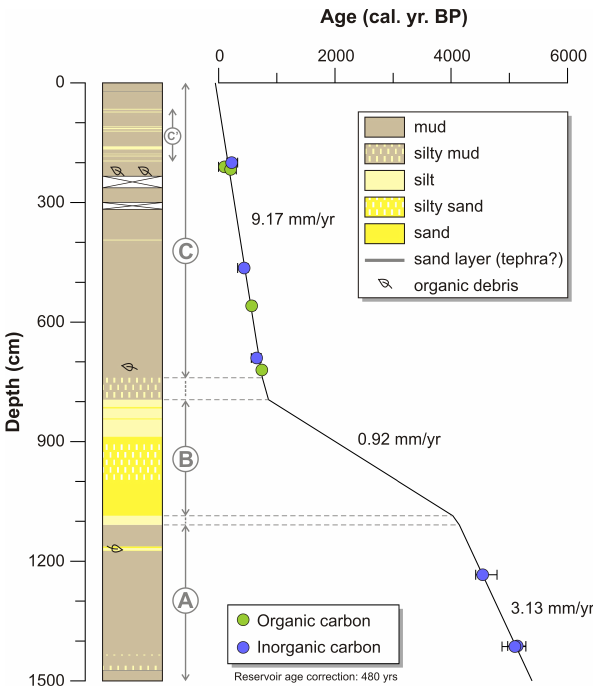
Fig. 2. Lithology and age model of sediment core JPC14. Most of the dots are larger than the error bar that represents the 2 σ range of the calibrated ages. The circled letters refer to the main lithological units discussed in the text (see Sect. 4.1). Radiocarbon ages are listed in Table